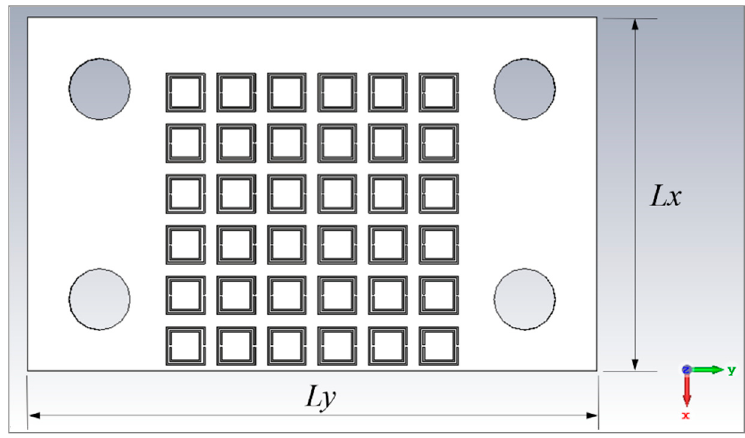
Figure 5. Layout of the SRR metamaterial placed as the patch antenna superstrate. Table 2. List of the geometric parameters of the SRR Unit Cell of Figures 2, 4 and 5.